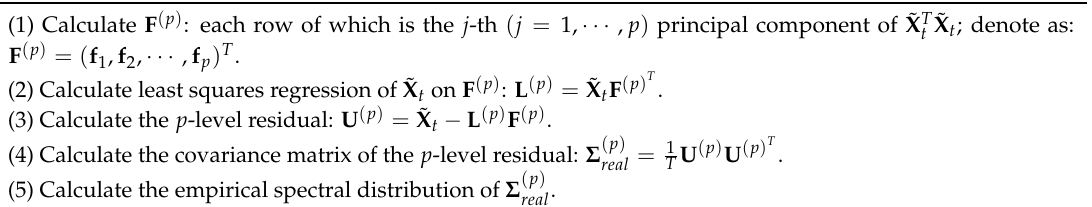
Table 1. Steps of calculating ρ real ( p )